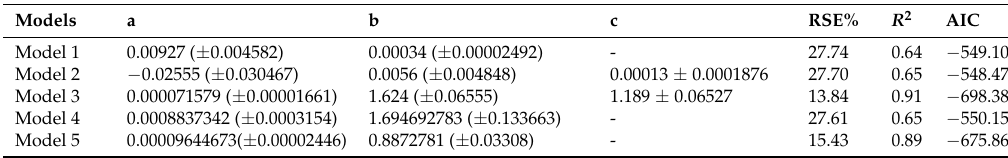
Table 1. Coefficients and statistics of five allometric models (Models 1–5) for estimating Rosewood tree volume ( n = 108 − category 1) in commercial plantations in Central Amazon. Each coefficient (a–c) is shown with the standard error in parentheses. The degree of fitness is indicated by percentage of residual standard error (RSE%), adjusted determination ( R 2 ) coefficient, and Akaike information criterion index